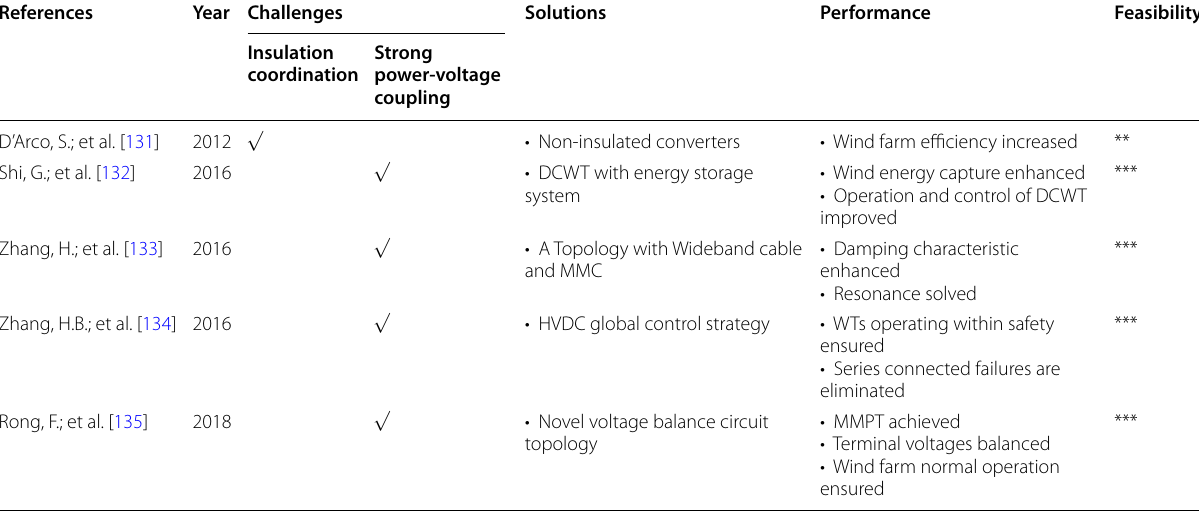
Table 7 Challenges and solutions for series-connection